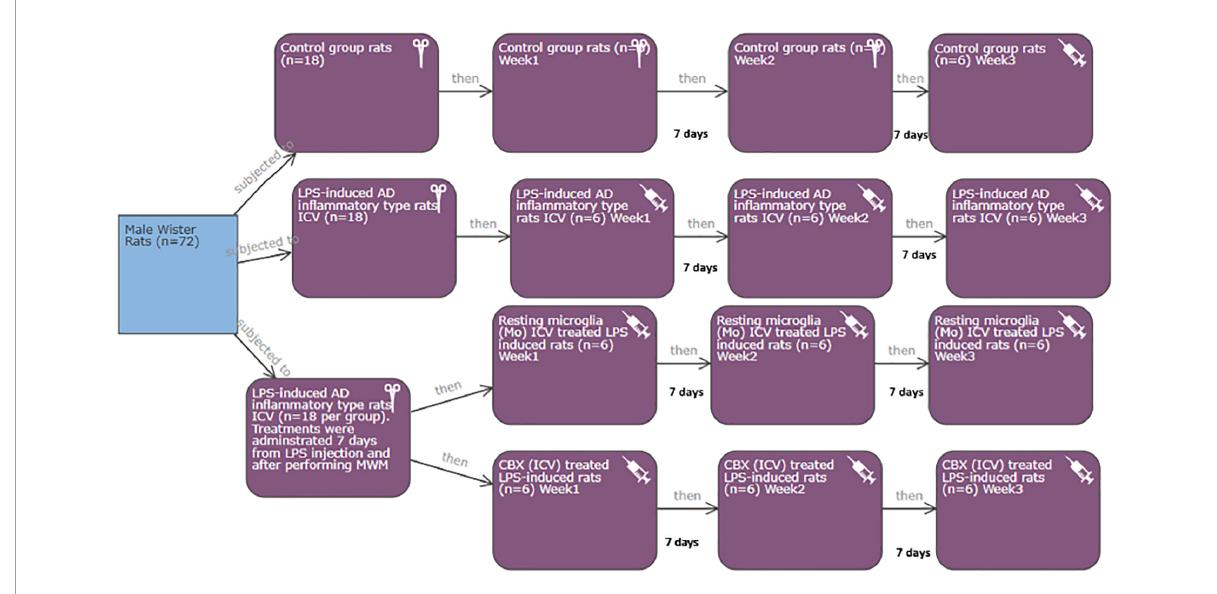
FIGURE2 Illustration of the conducted experimental